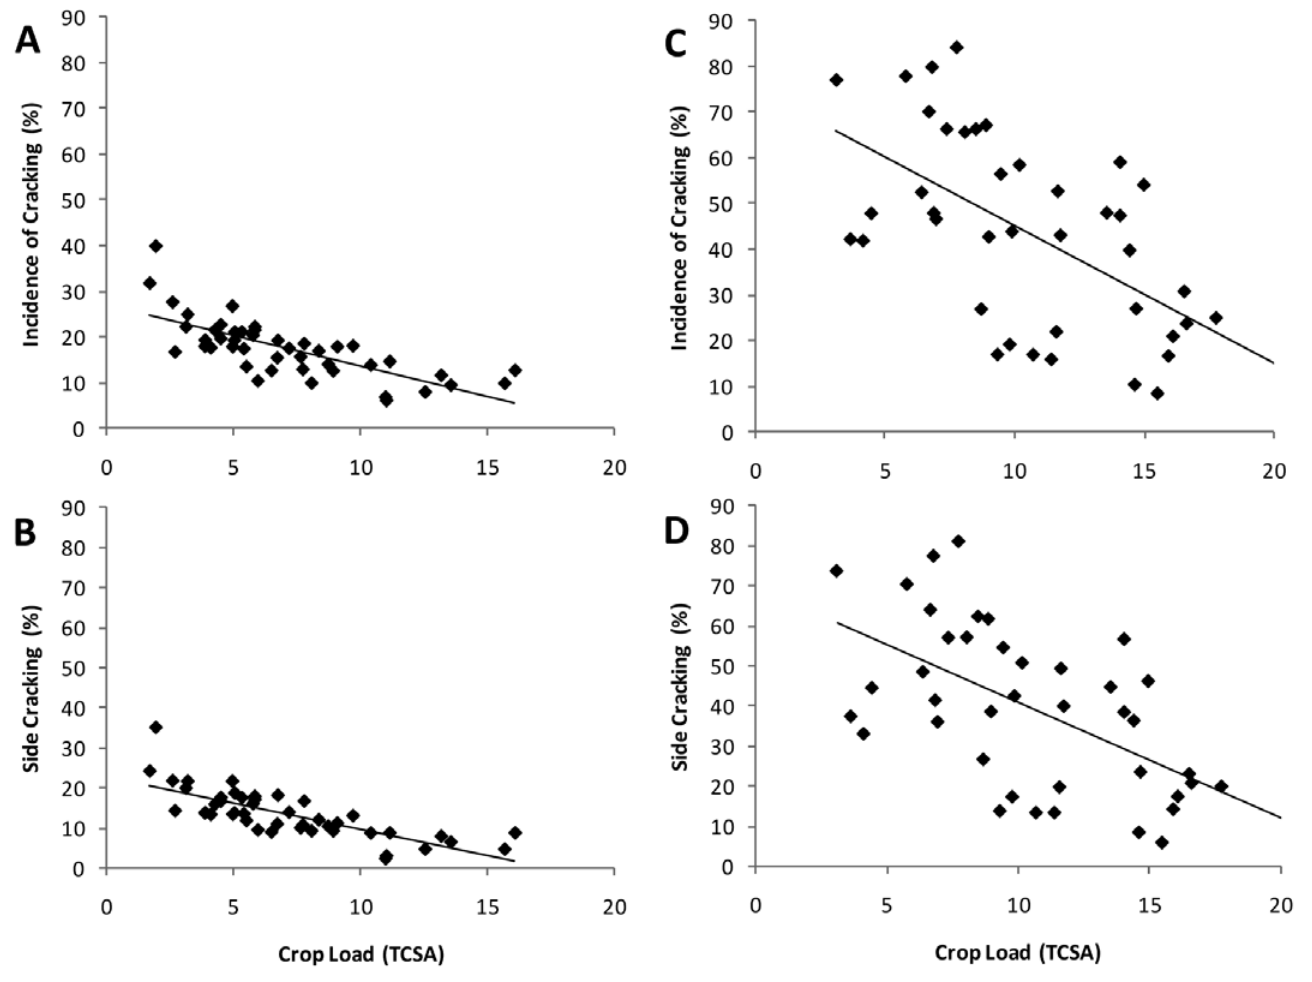
Fig. 3 - Percentage of total cracked fruit (A) (R 2 = 0.69) and side-cracked fruit (B) (R 2 = 0.59) with actual crop load (TCSA) for variety ‘Regina’ and percentage of total cracked fruit (C) (R 2 = 0.33) and side-cracked fruit (D) (R 2 = 0.32) with actual crop load (TCSA) for variety ‘Sweetheart’. Each point is for an individual tree. Significant relationships were found between crop load and total cracking incidence and between crop load and